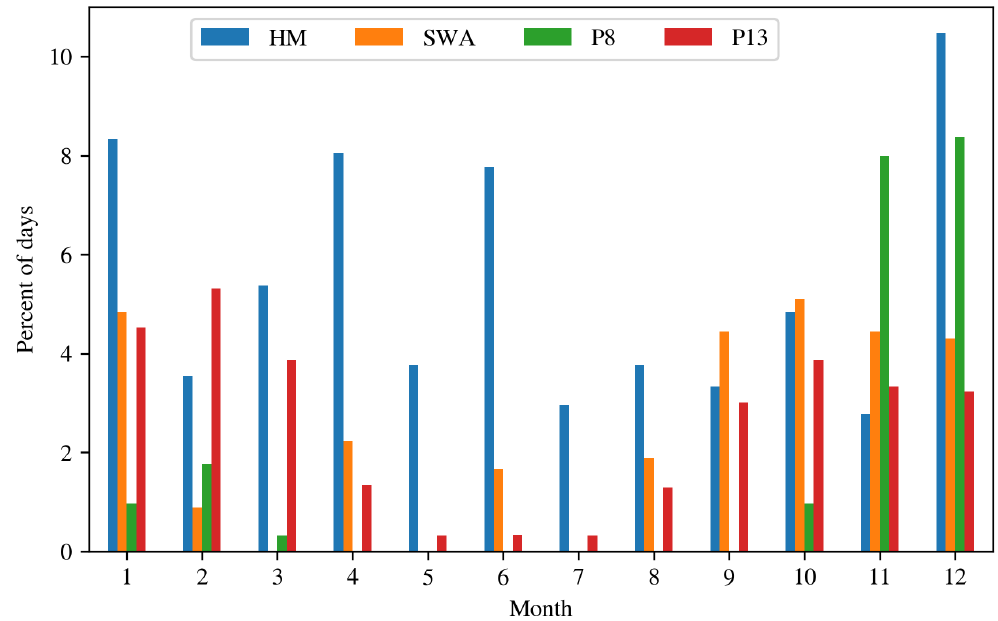
Figure 11. Average days of occurrence per month of the weather pattern in Figure 10 in